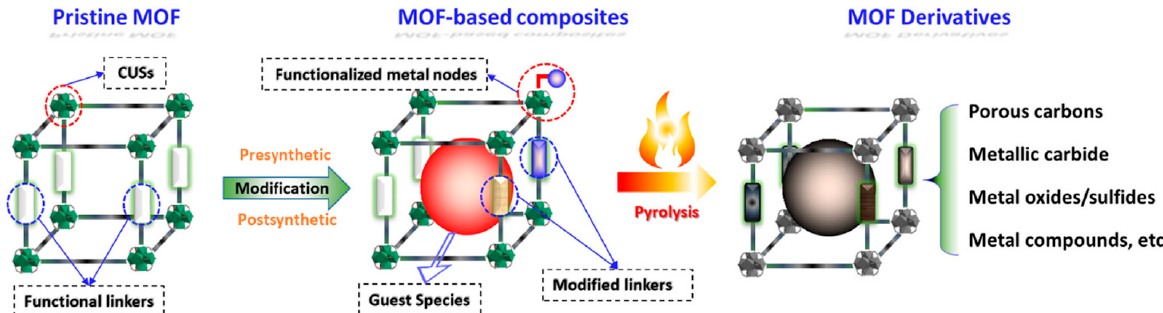
Figure 7. Schematic representation of the catalytic site locations on/in different types of MOF-based catalysts. Reprinted with permission from ref. [189]. Copyright 2019 Elsevier.